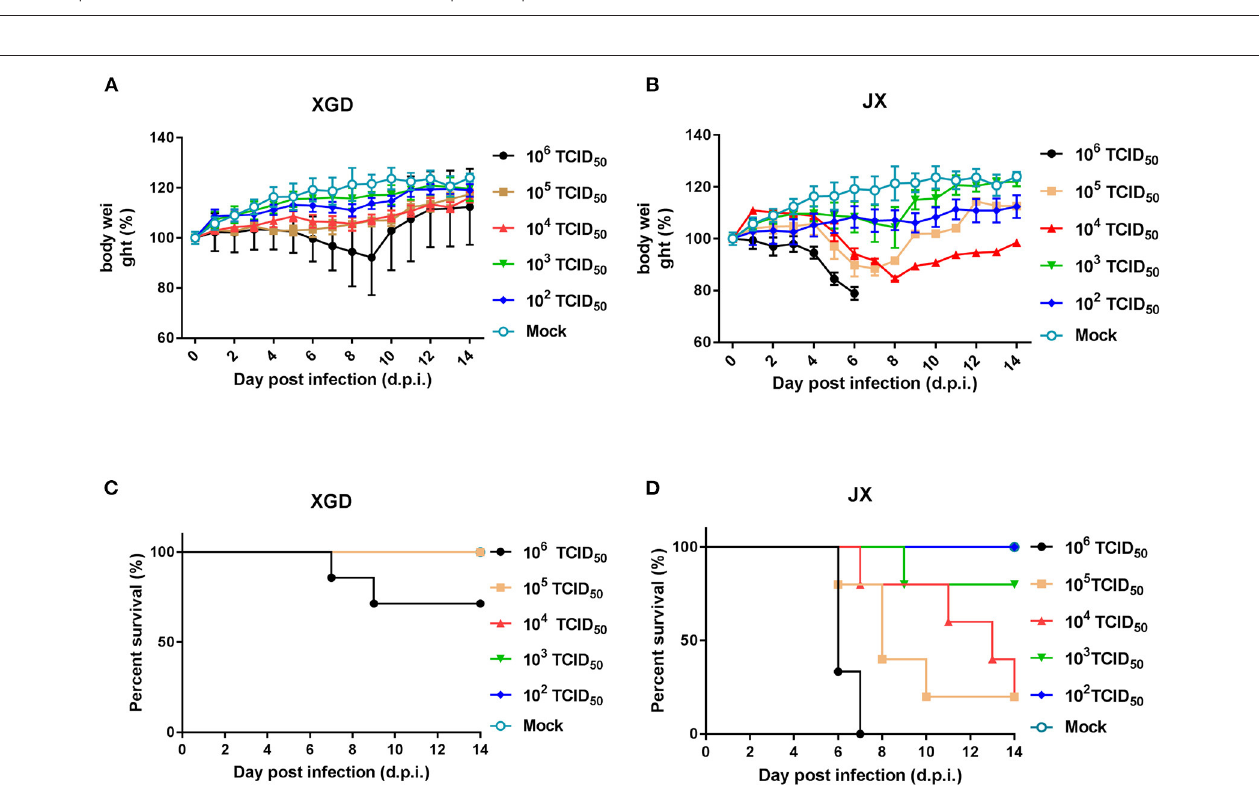
FIGURE 3 | Weight loss and survival of mice infected with the XGD and JX strains of H5N6. Groups of mice ( n = 5) were intranasally infected with 10-fold serial dilutions (10 2 -10 6 TCID 50 ) of XGD or JX. Control mice were inoculated with phosphate-buffered saline (PBS). The infected mice were observed to monitor weight loss (A,B) and survival (C,D) for 14 days post-infection (dpi). The mock infected mice are shared between group XGD and